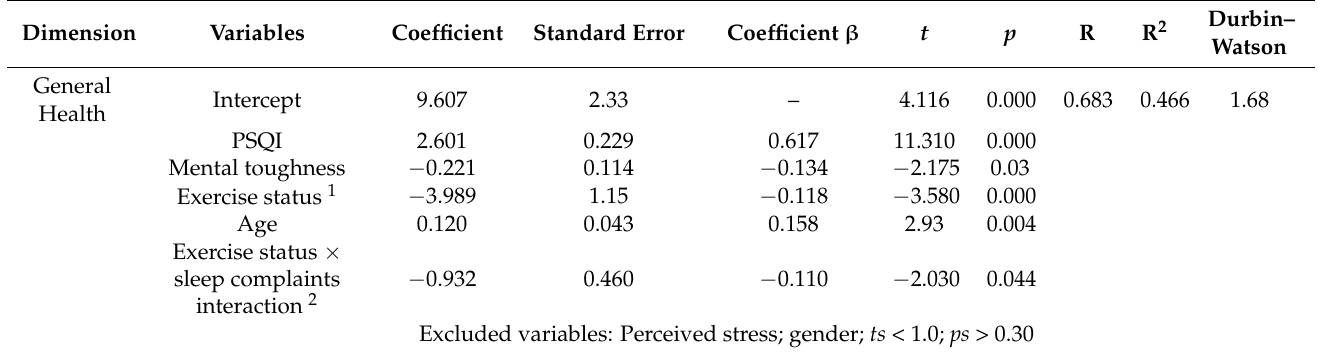
Table 4. Multiple linear regression with general health as outcome variable, and perceived stress, mental toughness, sleep disturbances, exerciser status, age, and gender as